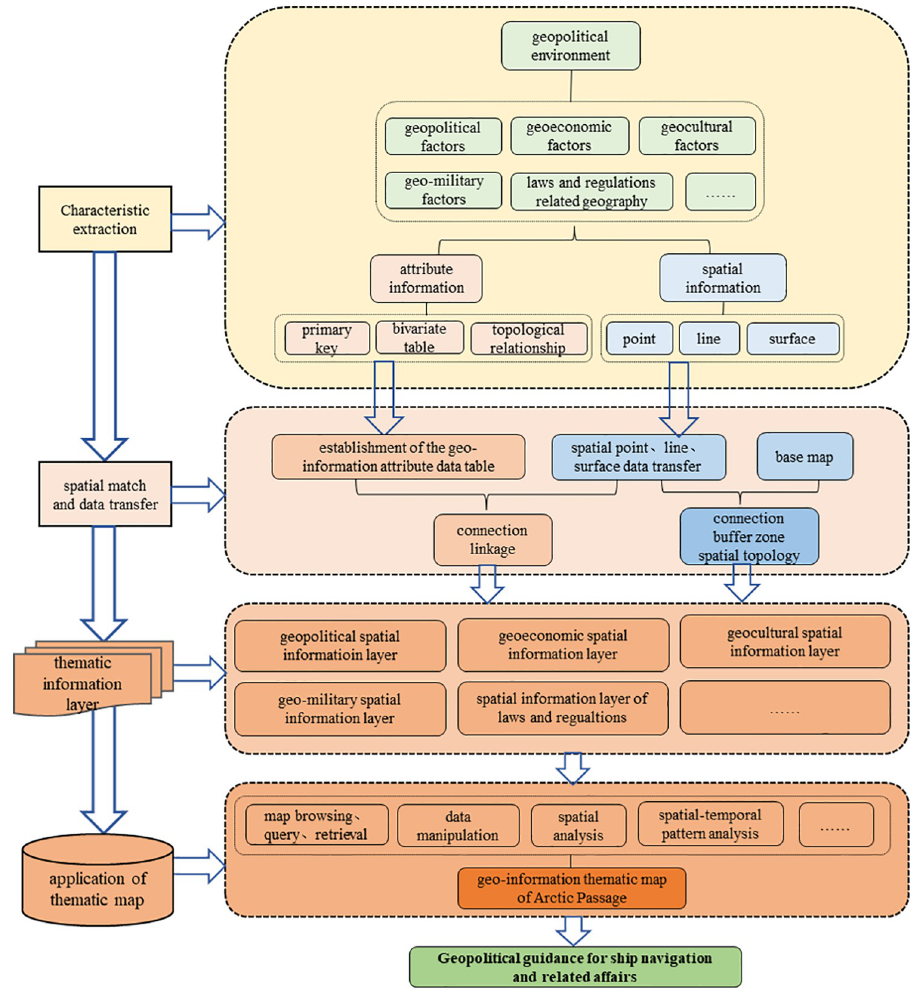
Fig 2. Framework of the spatial match and evaluation of geopolitical environment in Arctic